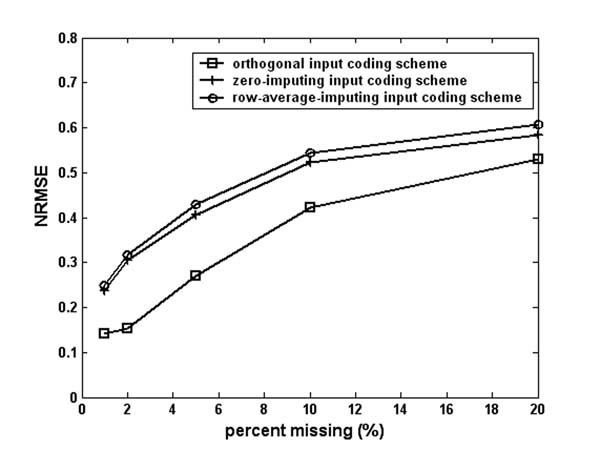
Influence of different input coding schemes on regression performance. The percentage of entries missing in the 'complete matrix' and the NRMSE of each input coding scheme are shown in the horizontal and vertical axes, respectively.